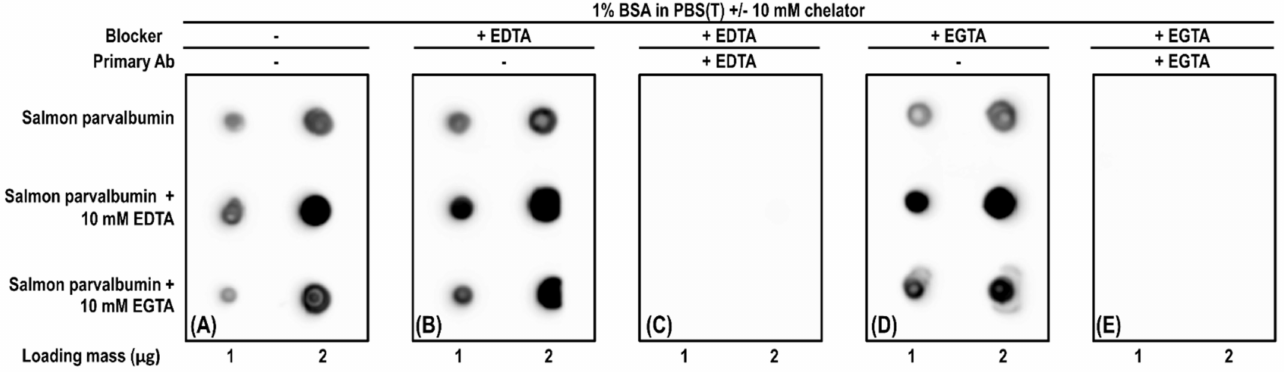
Figure 1. Effect of chelator on antibody-antigen interaction using dot blot. ( A , E ) Dot blot using mAb PARV19 (monoclonal anti-parvalbumin antibody, Sigma-Aldrich, P3088). ( B , C ) and ( D , E ) membranes were blocked using 1% (g/mL) BSA (bovine serum albumin) in PBS (10 mM phosphate-buffered saline, pH 7.2) containing 10 mM EDTA or 10 mM EGTA, respectively. ( C , E ) membranes were incubated with PARV19 diluted in 1% BSA in PBST (0.05% (mL/mL) Tween 20 in PBS) containing 10 mM EDTA or 10 mM EGTA,